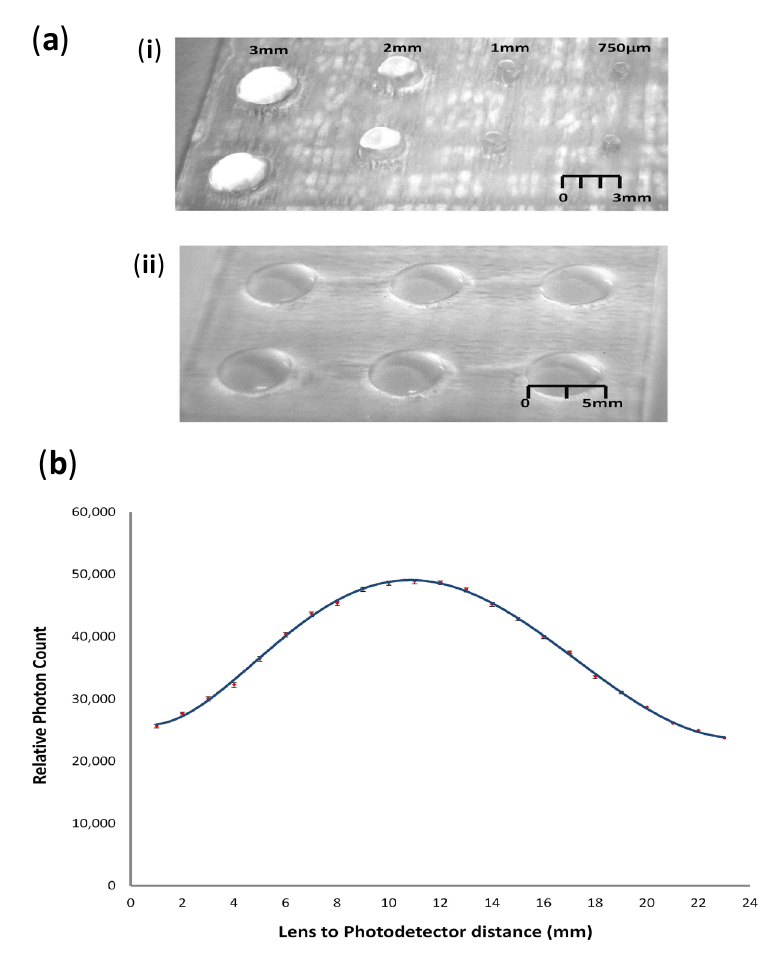
Figure 5. ( a ) Photographs of spherical PMMA lenses ( i ) of sizes of 3 mm, 2 mm, 1 mm and 750 um; and ( ii ) a 5 mm lens array, post-polishing and thermal annealing; ( b ) Results for the average focal length determination of several 5 mm-diameter spherical